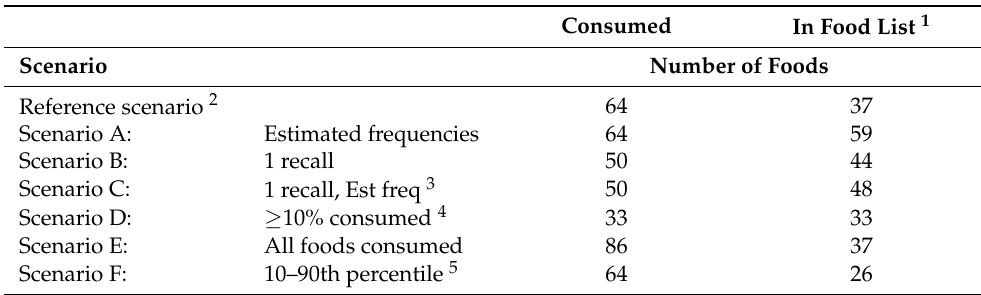
Table 5. Number of foods consumed and included in the food list per scenario for Kenyan children, 4–6 years of